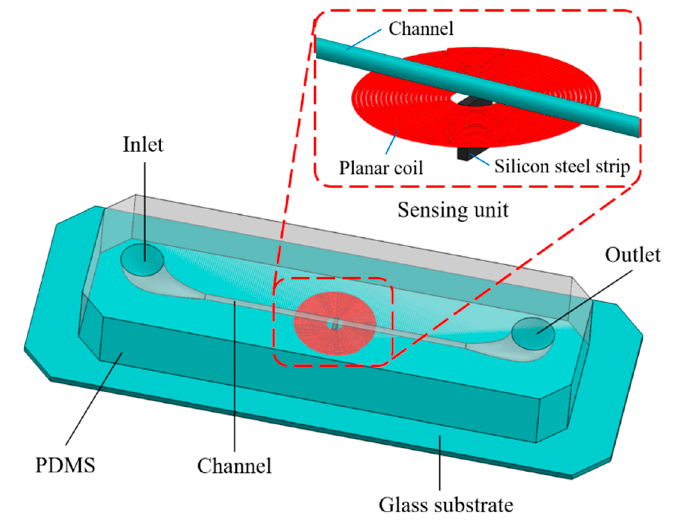
Figure 1. The structure of the inductive sensor.